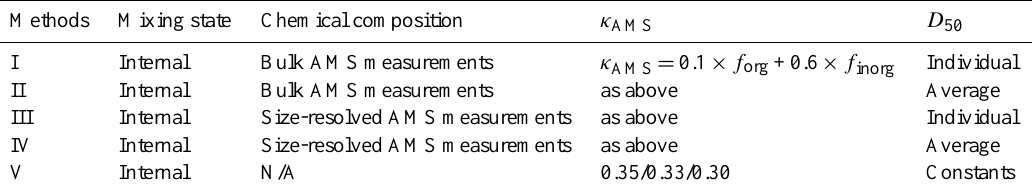
Table 3. Methods used in N CCN prediction based on the individual CCN scan and average D 50 over whole period from AMS measurement.